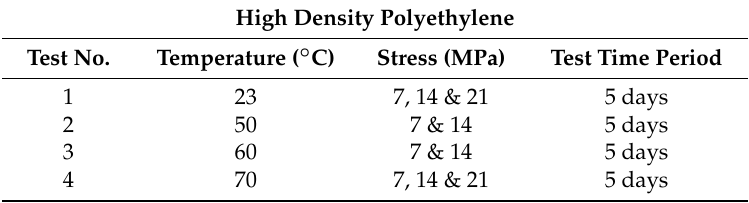
Table 2. Thermal ratcheting test